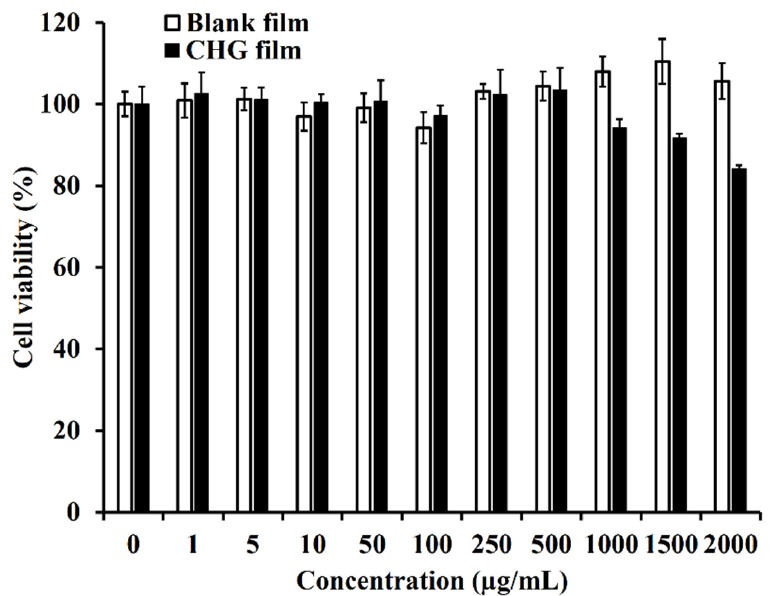
Figure 7. Indirect cytotoxicity of the films to the NHF cells. The cell viability was determined by the MTT assay. The experiment was repeated five times, and the results were presented as the mean ± SD.